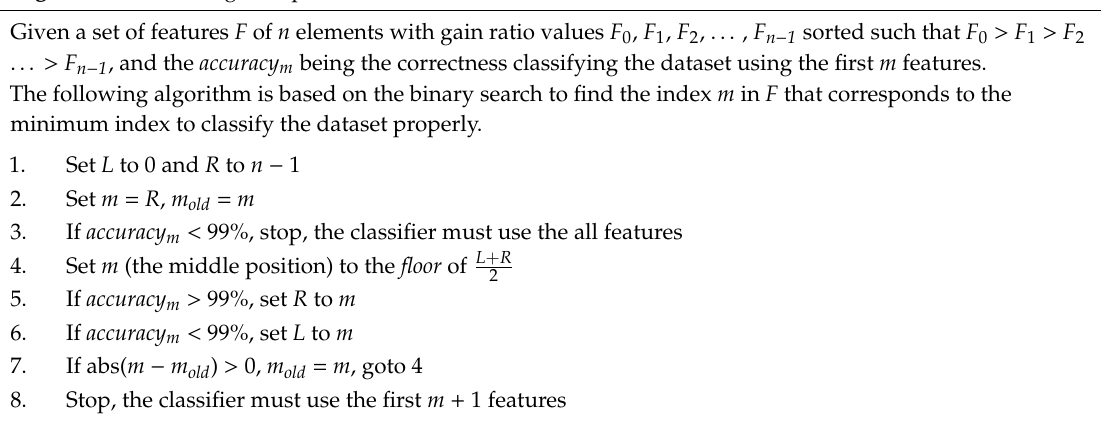
Algorithm 1 Searching the optimal number of